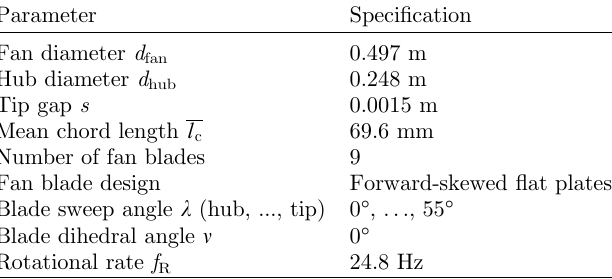
Table 1. Fan design parameters and operating